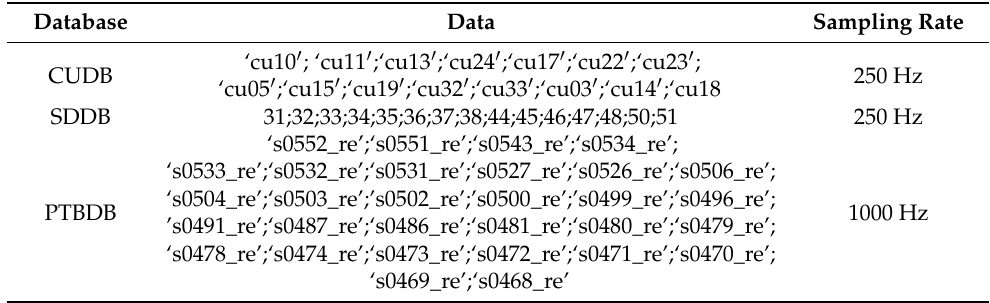
Table 1. Sixty selected ECG records from CUDB, SDDB, and PTBDB.